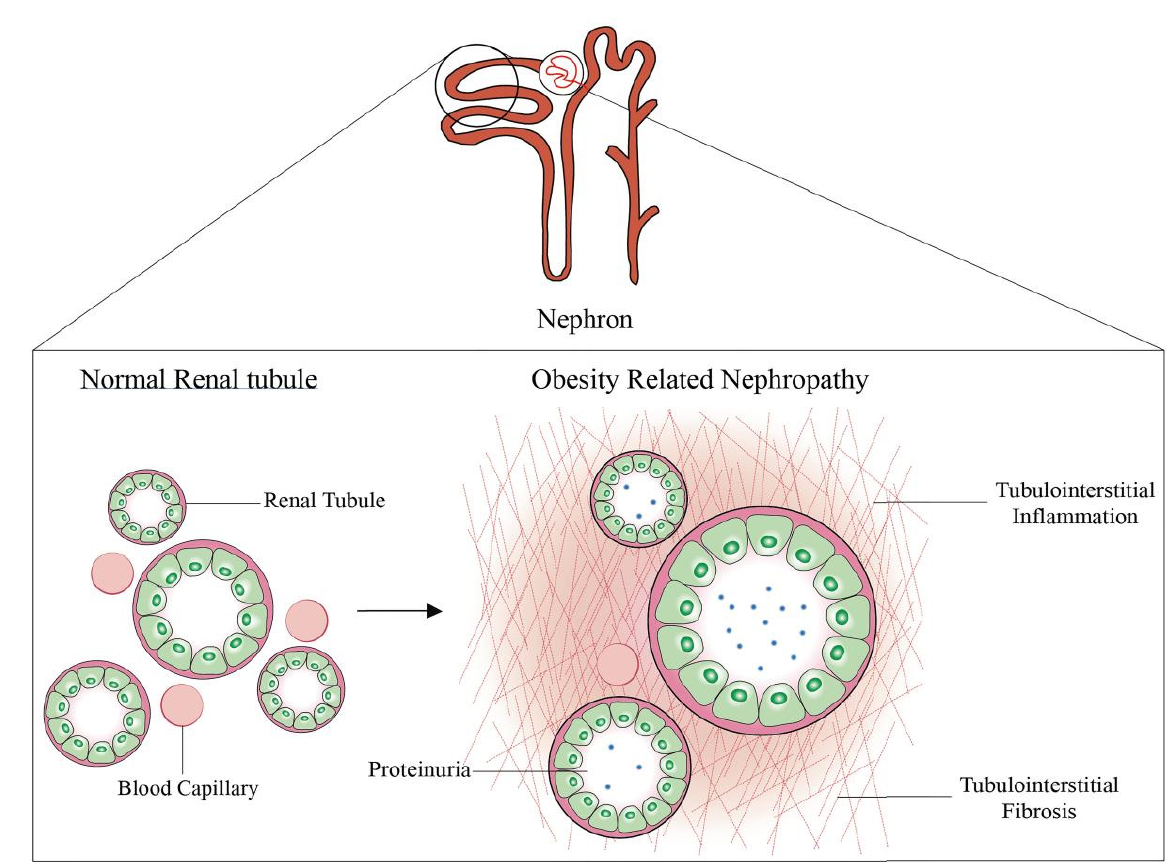
Figure 3 . The changes of renal tubules in obesity ‐ related nephropathy. Renal tubules are tubules surrounded by monolayer epithelial cells, which can reabsorb and secrete some components in urine. Obesity ‐ related kidney disease is characterized by tubular hypertrophy, basement membrane thickening and then interstitial inflammation and fibrosis, and it may thus set the stage for renal failure later in life. In the right picture, red indicates renal interstitial inflammation, and the line indicates renal interstitial fibrosis.